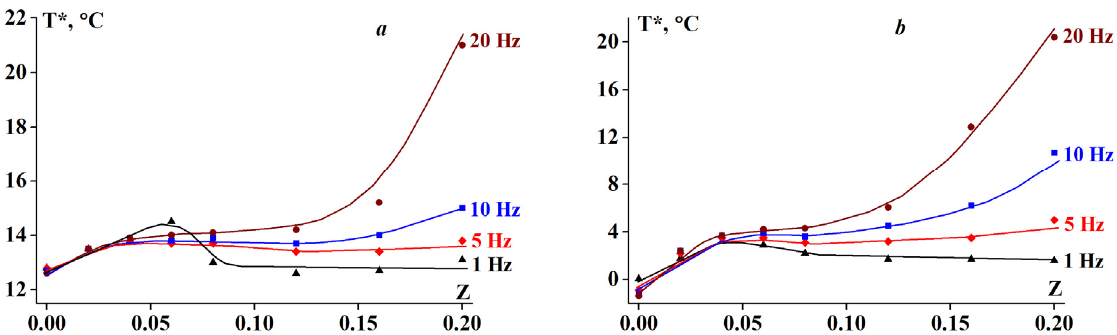
Figure 3. Transition temperature T* dependency on alginate-gelatin composition for ( a ) heating and ( b ) cooling at a tem- perature ramp rate of 2 K/min. G’, G’’ (and T* as their crossover points) were obtained at the frequencies shown on the curves.